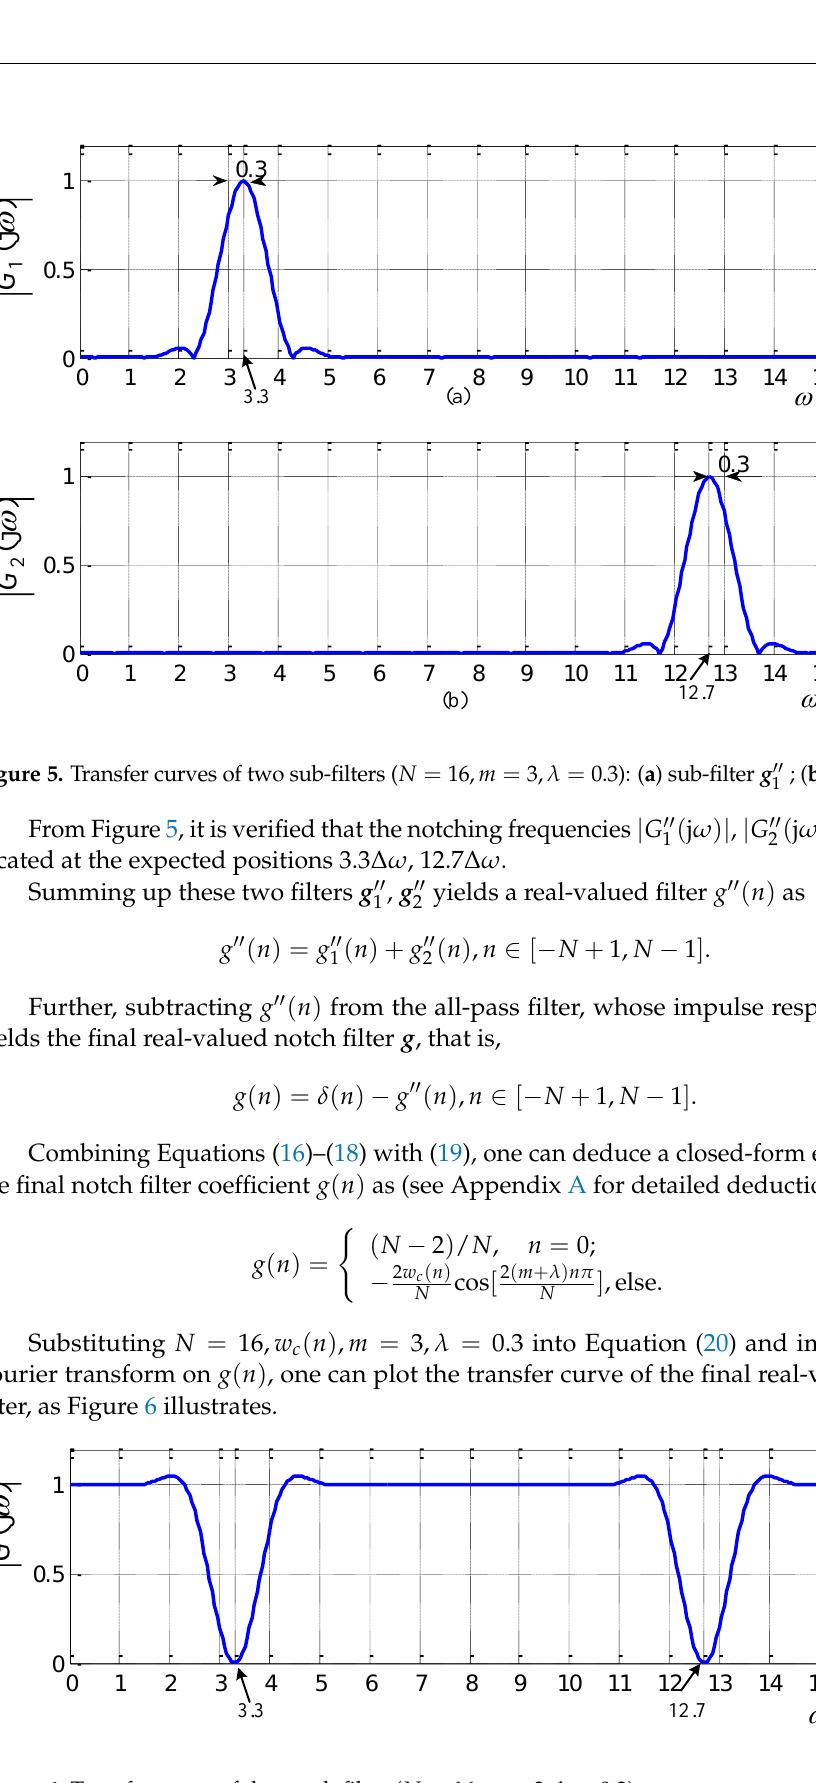
Figure 6. Transfer curve of the notch filter ( N = 16, m = 3, λ =